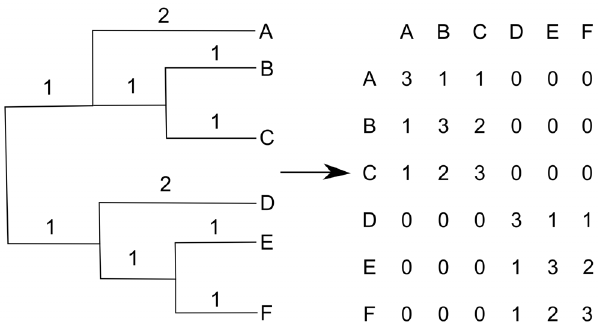
Figure 2. Variance-covariance matrix of a generalized phylo- genetic tree. Variance is set to the branch length from the root to the tip and the covariance is the branch length from the root to the most recent common ancestor (adapted from de Villemereuil et al.